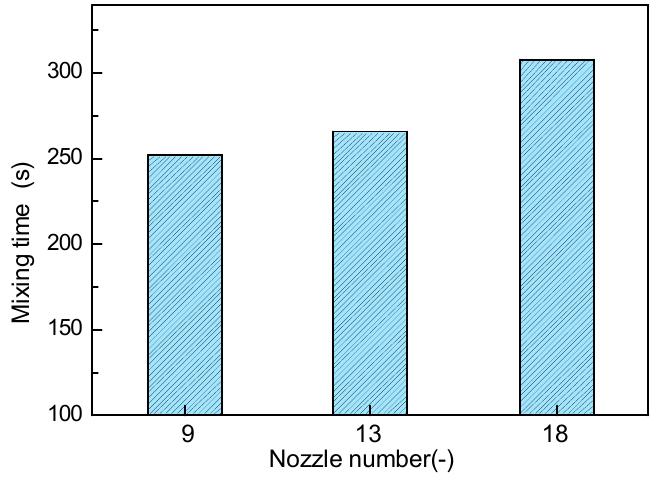
Figure 14. Effect of different nozzle number on the predicted and measured mixing time in the bath.